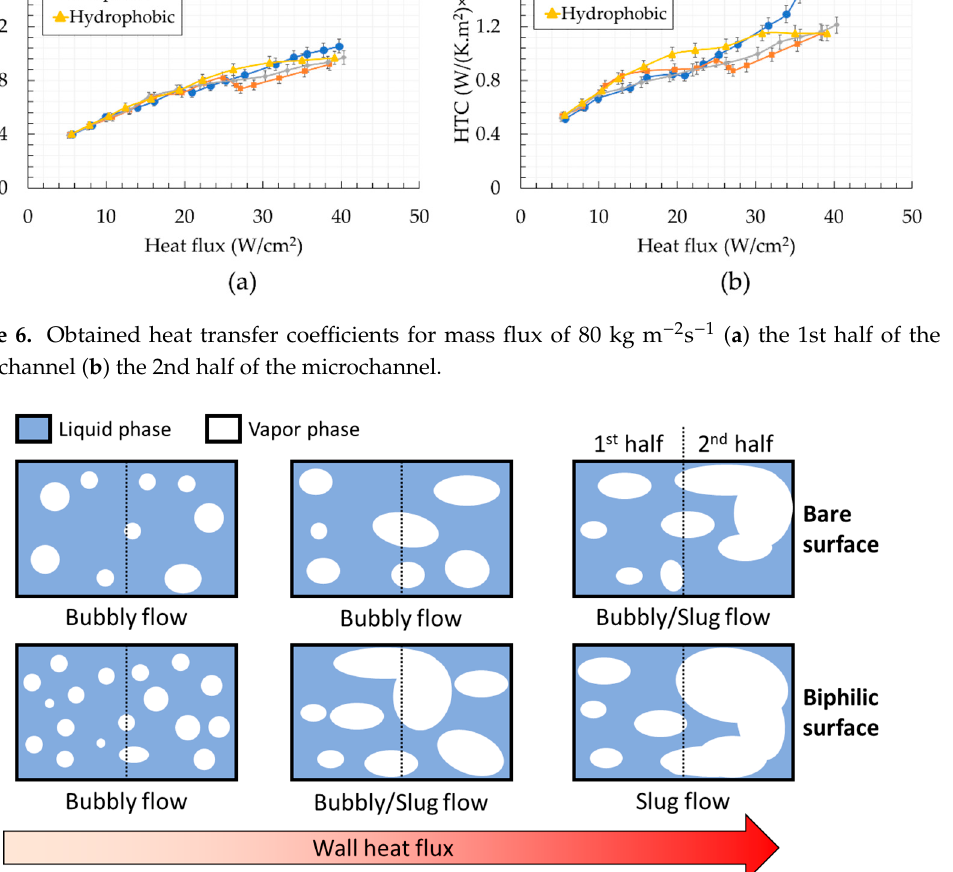
Figure 7. Schematic of flow map transition on biphilic surfaces.